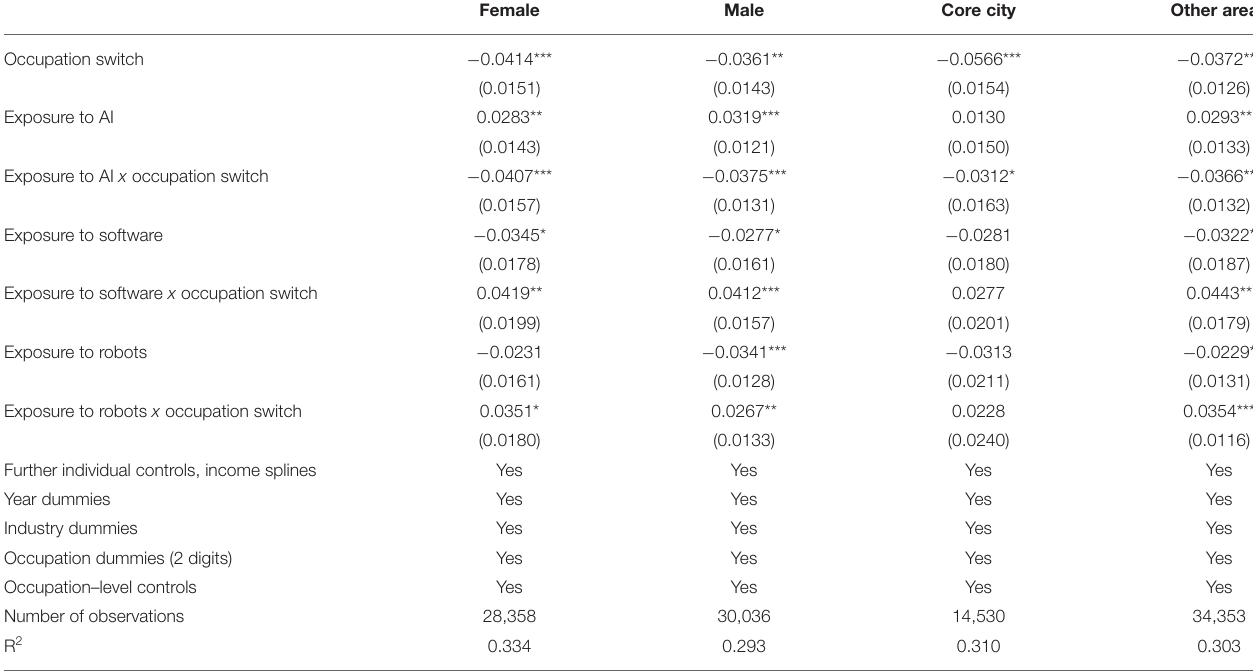
TABLE 5 | Technology exposure and annual wage growth by